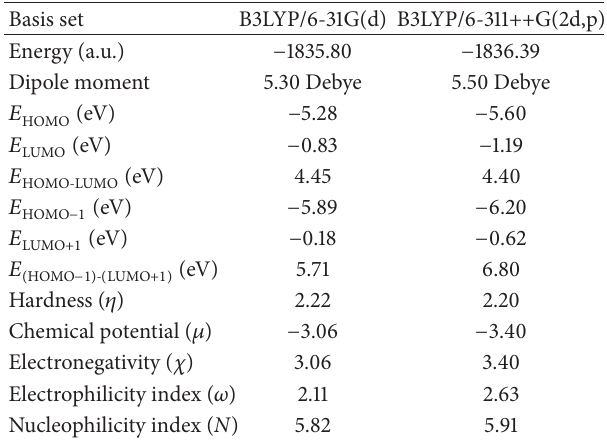
Figure 3: Experimental and theoretical ultraviolet-visible spectra of strictosidine in methanol.